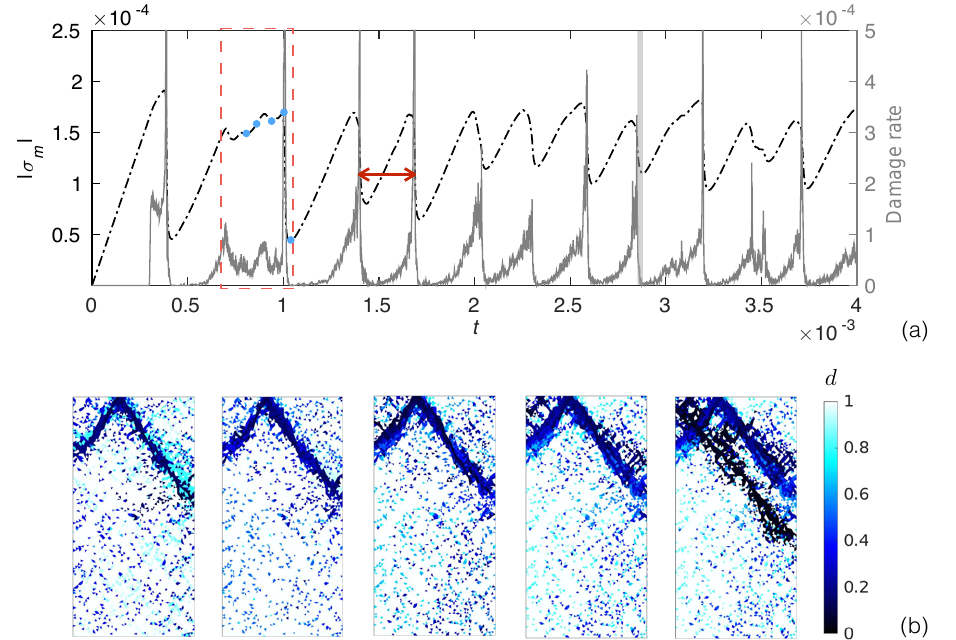
Figure 8. (a) Macroscopic stress (black dashed/dotted line) and damage rate (solid grey line) as a function of time for one realization of the uniaxial compression experiment with N = 40. The dashed red box indicates an interval of uninterrupted damaging activity, during which deformation is accommodated by a persisting system of interacting faults. (b) Instantaneous fields of the level of damage at the five times indicated by the blue dots on the macroscopic stress curve, showing the formation of the system of faults (first panel), which remains active for some time (three following panels), until the propagation of a new, non-interacting fault (last panel).